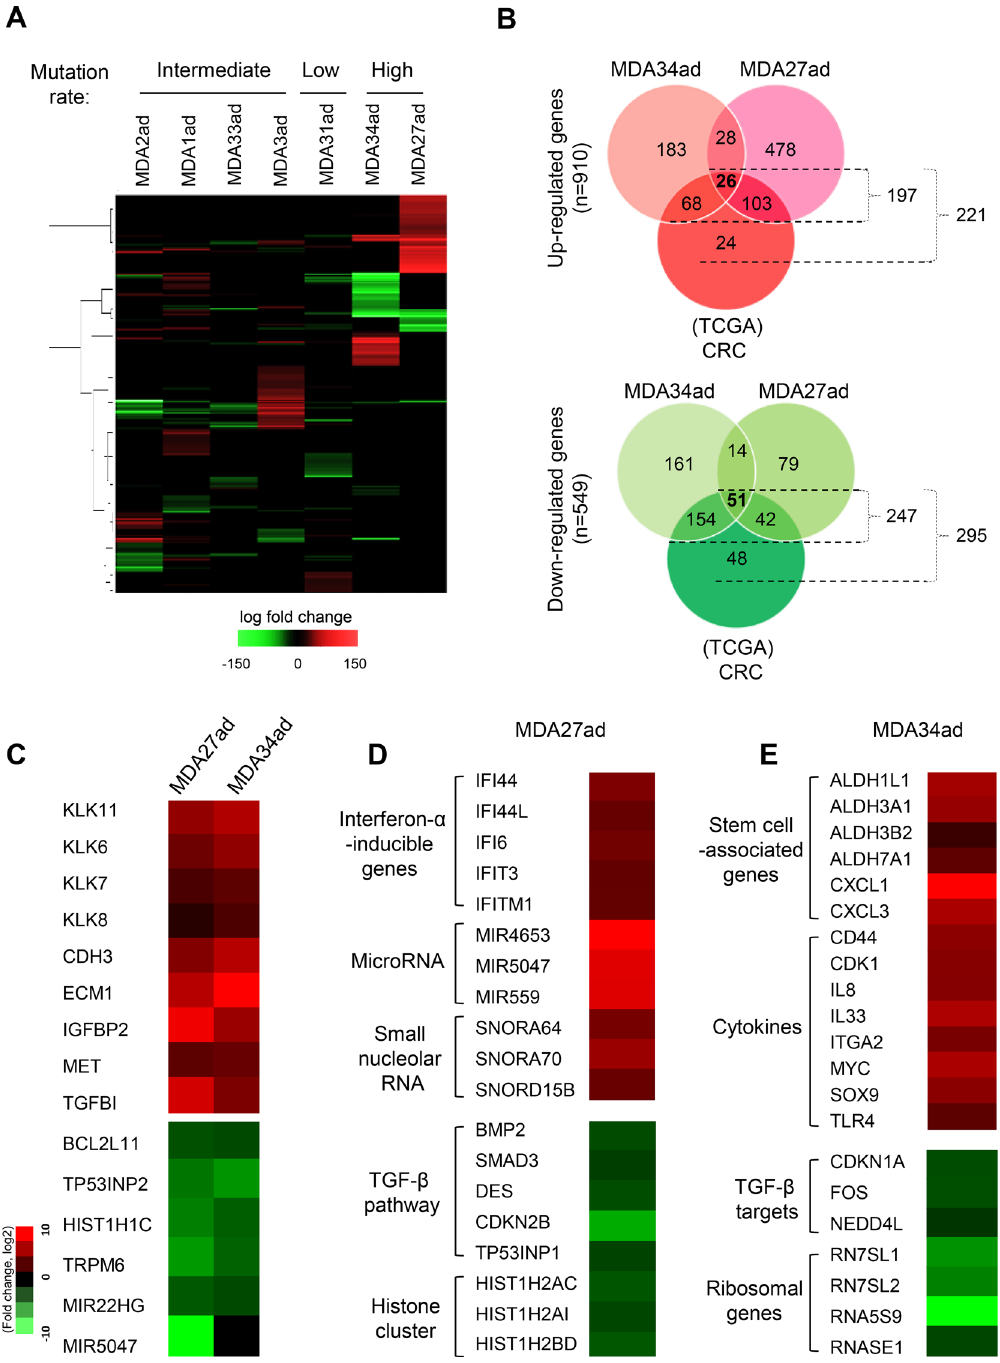
Fig 2. Unsupervised hierarchical clustered transcriptomic analysis reveals distinct gene expression signatures. (A) The clustering heat map reveals a unique cluster of gene signatures in two of the highly mutated adenoma samples, MDA34ad-TVA and MDA27ad-TA. The heat map was obtained using the 7 adenoma samples with the Ward hierarchical clustering algorithm and Euclidean distance metrics. The samples are classified as intermediate, low, and high based on the mutation rates observed. A unique cluster of genes was identified in two of the highly mutated adenoma samples, MDA34ad-TVA and MDA27ad-TA. (B) Venn diagram representing the CRC TCGA data set and the 2 highly mutated adenoma samples which show the unique cluster of genes. The red Venn diagram represents the genes (n = 910) that are up-regulated among the 2 highly mutated adenoma samples and the TCGA data set while the green indicates the genes (n = 549) that are down-regulated as observed among the 2 highly mutated adenoma samples and the TCGA data set (cut-off, log2fold change ± 1.5). (C) The commonly altered genes which are observed in two adenoma samples, MDA27ad-TA and MDA34ad-TVA. The representative gene expressions are shown. (D) Representative altered gene expressions are shown in adenoma sample MDA27ad-TA. (E) Representative altered gene expressions are shown in adenoma sample MDA34ad-TVA. doi:10.1371/journal.pone.0153933.g002 PLOS ONE | DOI:10.1371/journal.pone.0153933 April 21,